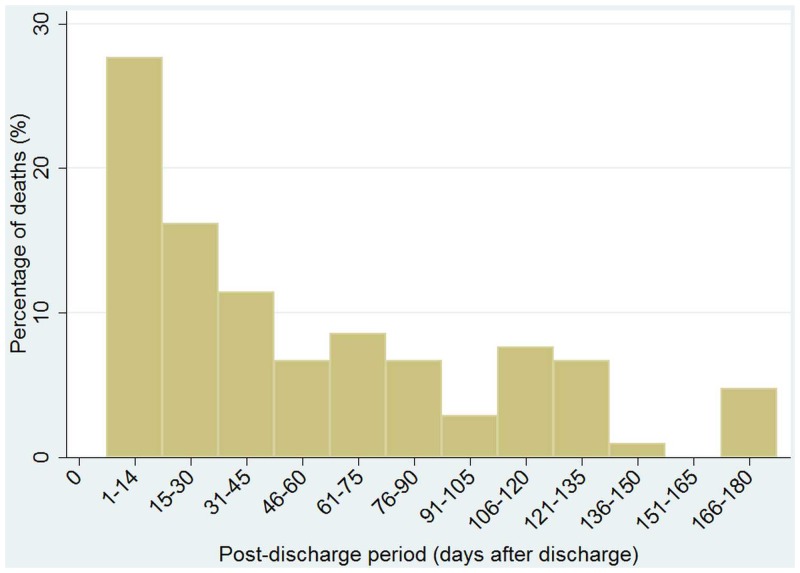
Temporal distribution of 105 deaths during 180 day follow-up after discharge from Basse Health Centre.Fifty-five patients exited alive from the Basse HDSS during 180 day follow-up.